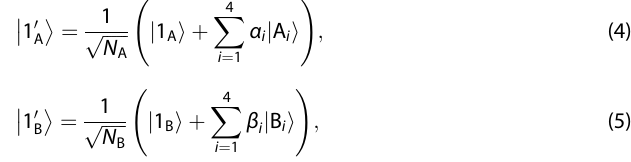
P P ^ c y ^ c Here, ^ H t ¼ σ t ij j σ is nearest-neighbor tunneling, with i σ <i ; j> spin index σ = { ↑ , ↓ } and QD indices i , j run from dots 1 – 3 (4 – 6) for qubit A (B). Tunnel couplings t 12 ≡ t lA , t 23 ≡ t rA , t 45 ≡ t lB , and t 56 ≡ t rB . There is no tunnel coupling between the TQDs, i.e., t